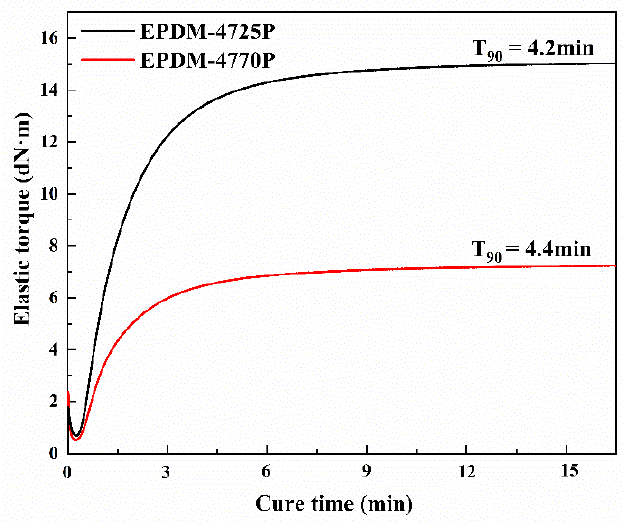
Figure 1. Crosslinking curve of EPDMs at 180